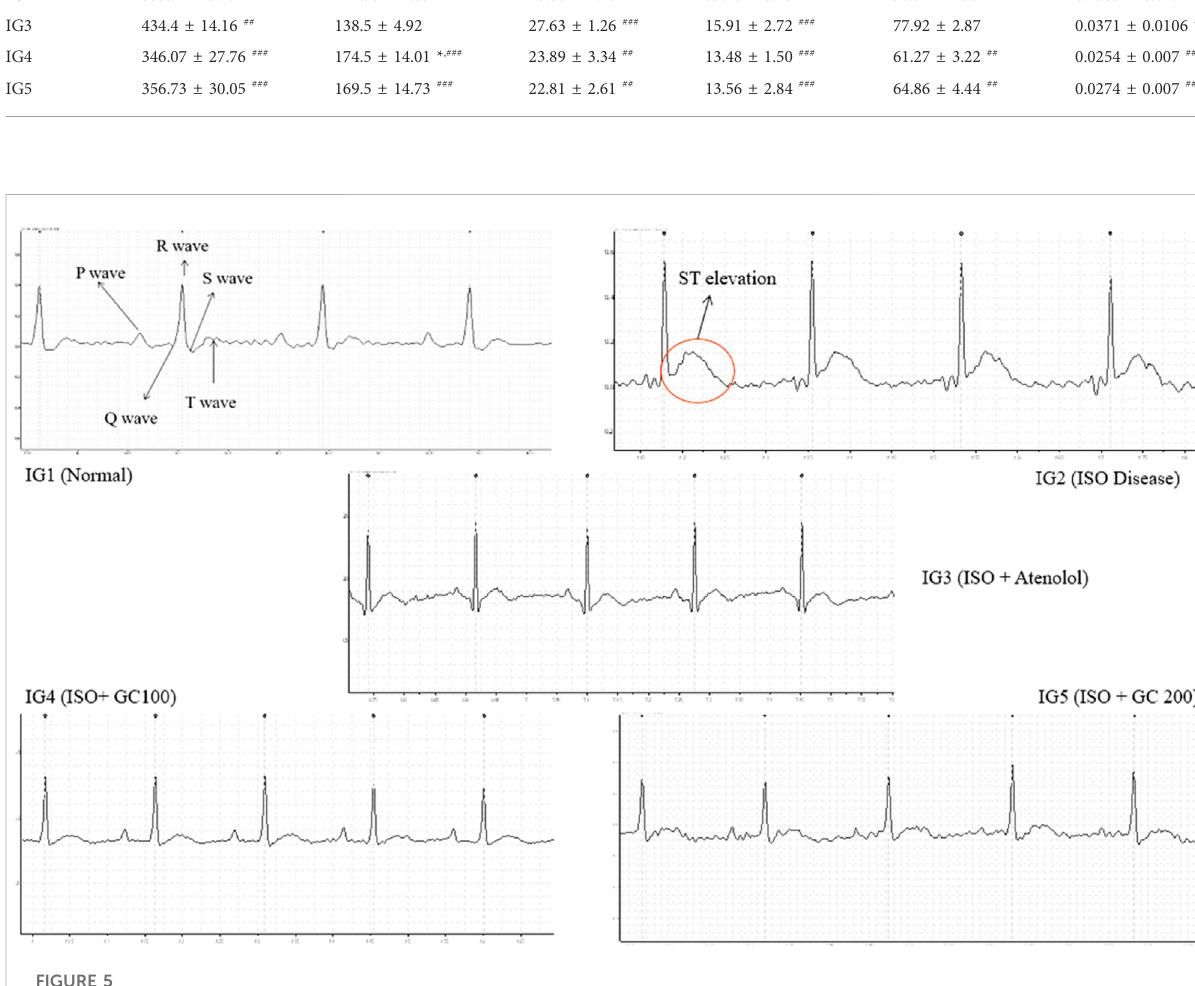
FIGURE 5 Representative electrocardiograph recordings of all the experimental groups, with evident ST elevation found in ISO treated disease